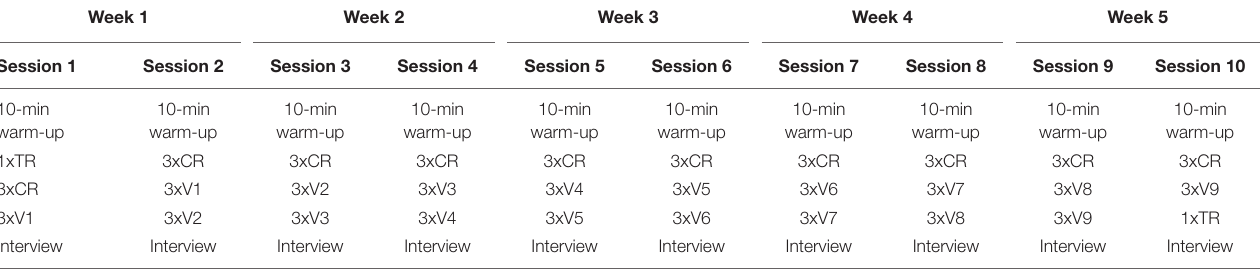
TABLE 1 | Organization of the learning